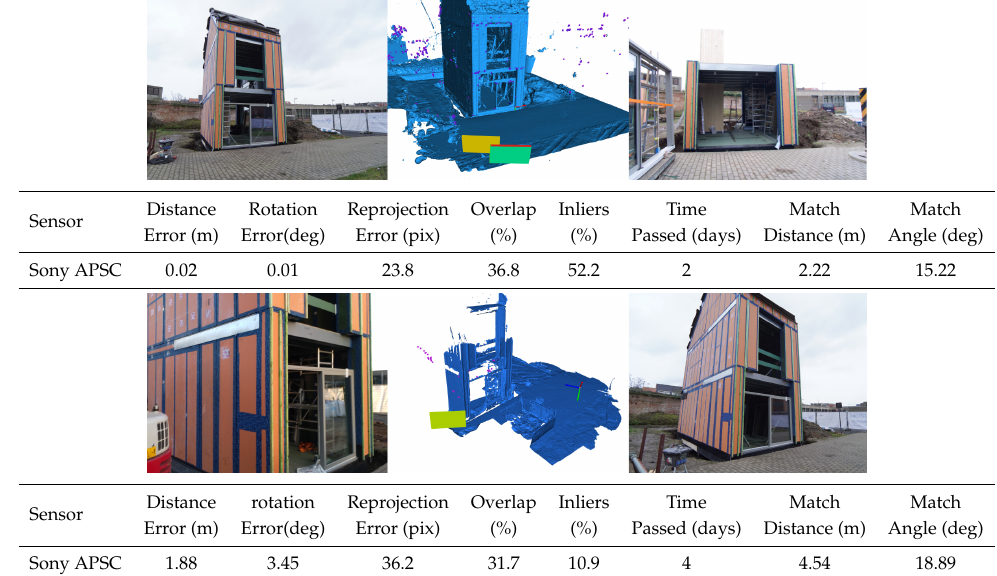
Table 6. Two-dimensional matching estimations based on 1 reference image and a